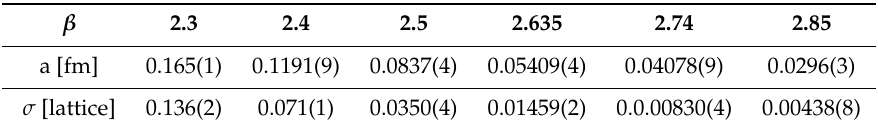
Table 1. The values of the lattice spacing in fm and the string tension corresponding to the respective value of β are based on [12–16] by setting the physical string tension to ( 440 MeV ) 2 .